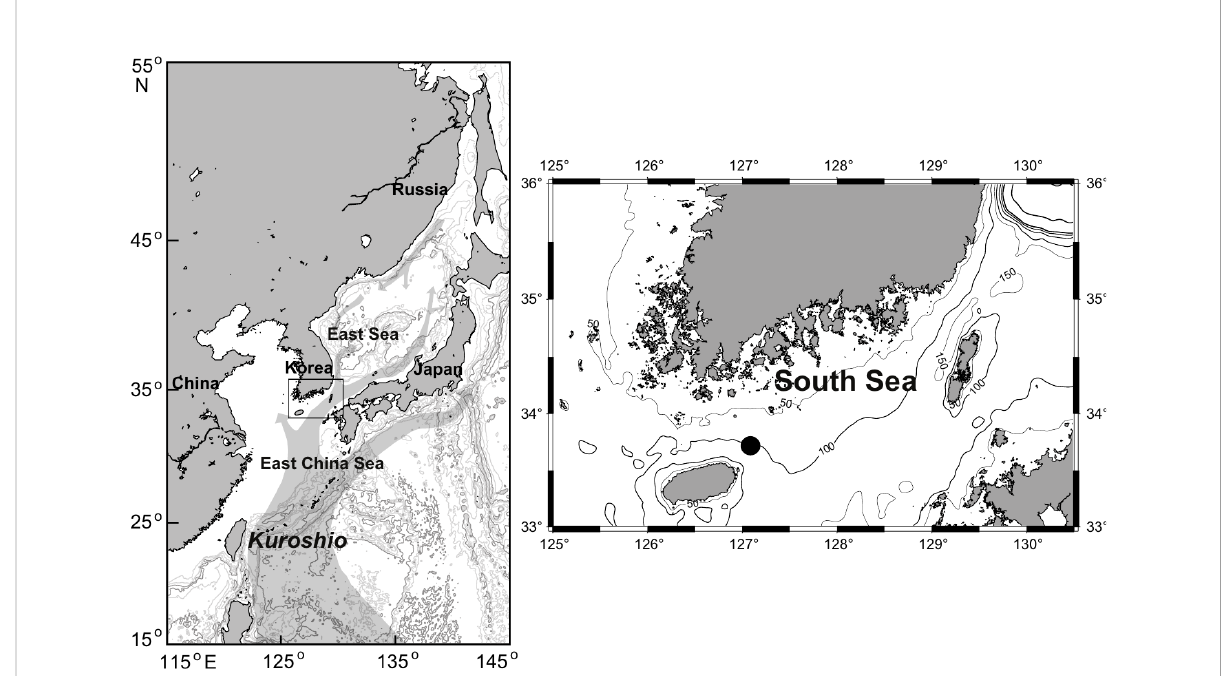
FIGURE 1 Map of the sampling area in the South Sea of Korea. Field circle indicates the sampling site collected for zooplankton, large-head hairtail ( Trichiurus japonicus ), and other fi